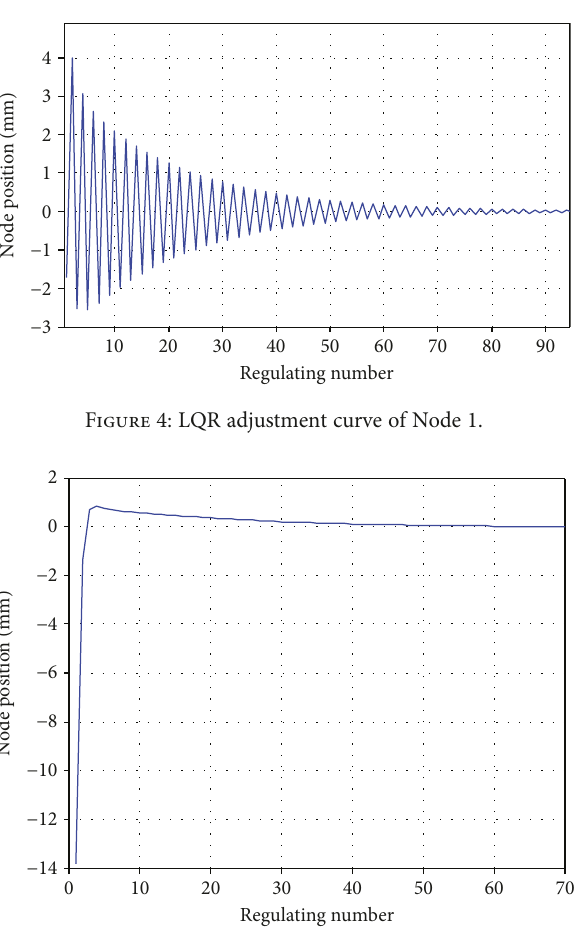
Figure 5: ARDFD adjustment curve for Node